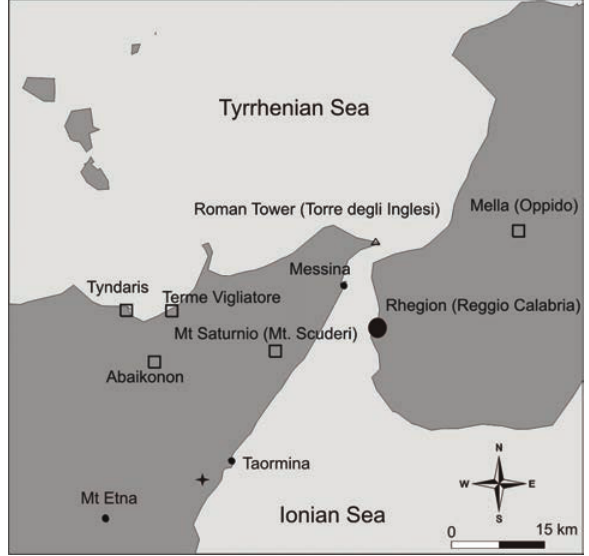
Figure 5. The 17 AD earthquake according to Boschi et al. [2000]: Reggio and the epicenter shown by the asterisk south of Taormina; the 1st century (14-37 AD ?) earthquake/s according to this work: Reggio and the localities shown by unfilled squares. At the Torre degli Inglesi site a sandy layer interpreted as tsunami deposit dated AD 0-125 [Pantosti et al. 2008] was found (see